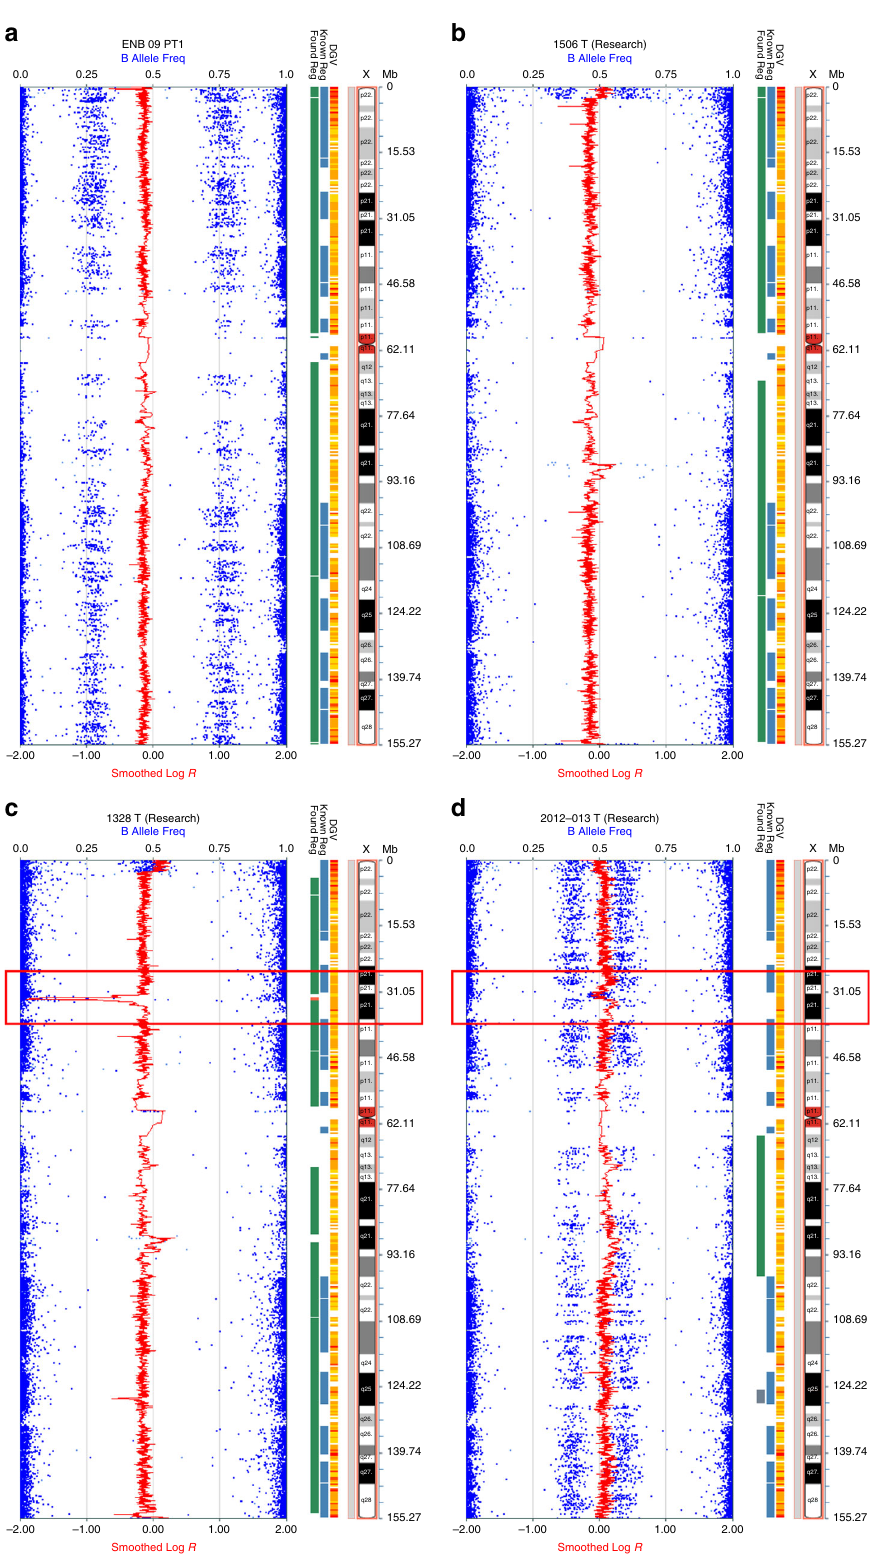
Fig. 1 SNP array analysis of X chromosomes in representative ONB tumor samples. a An ONB, from a female patient, with mosaic loss of the X chromosome (ENB09PT1, Table 1) as indicated by the left shift of Log R and change of B allele frequencies. b An ONB, from a male patient, with no evidence of deletion in DMD (ENB1506T, Table 1). c An ONB, from a male patient, harboring a deletion in DMD (ENB1328T, Table 1). d An ONB, from a female patient, harboring a deletion in DMD (ENB2012-13T, Table 1); the right shift of Log R and change of B allele frequencies indicate the presence of mosaicism with relative gain of the X chromosome and deletion in DMD in a percentage of the tumor